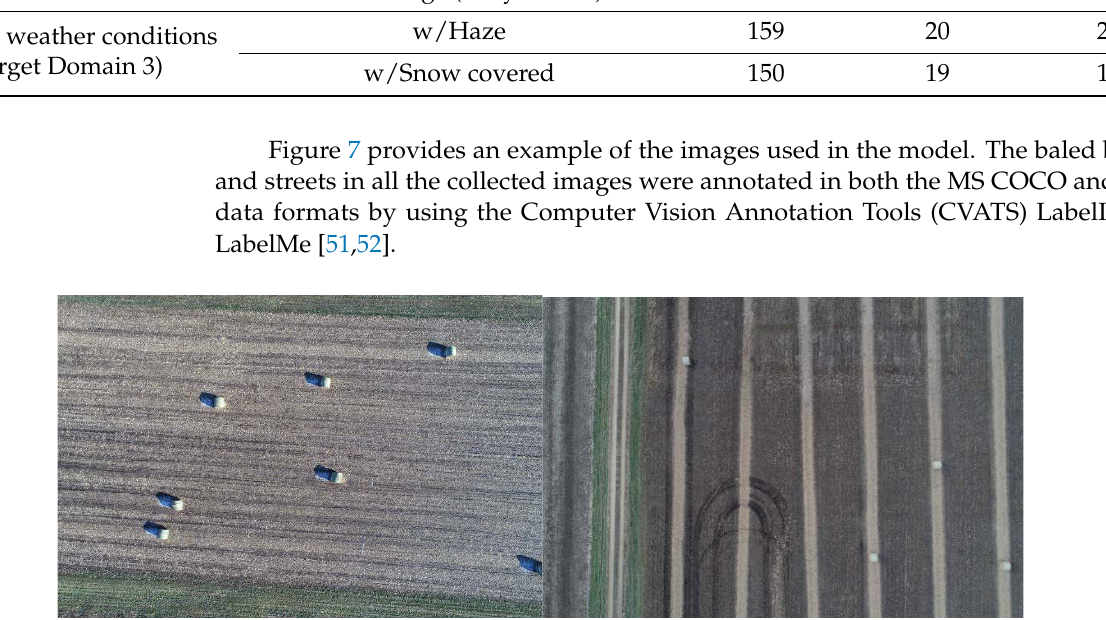
Table 3. YOLOv3 model (trained in Step 1) performance for detecting bales in different conditions without being trained with synthetic images.